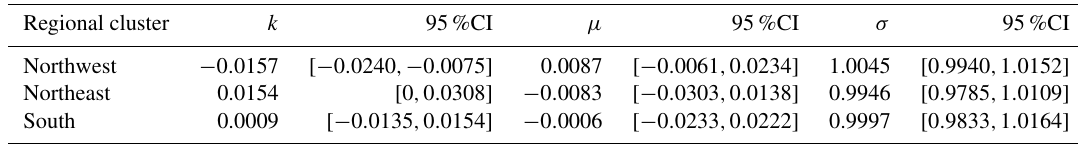
Table 2. Confidence intervals for transformed regional models.